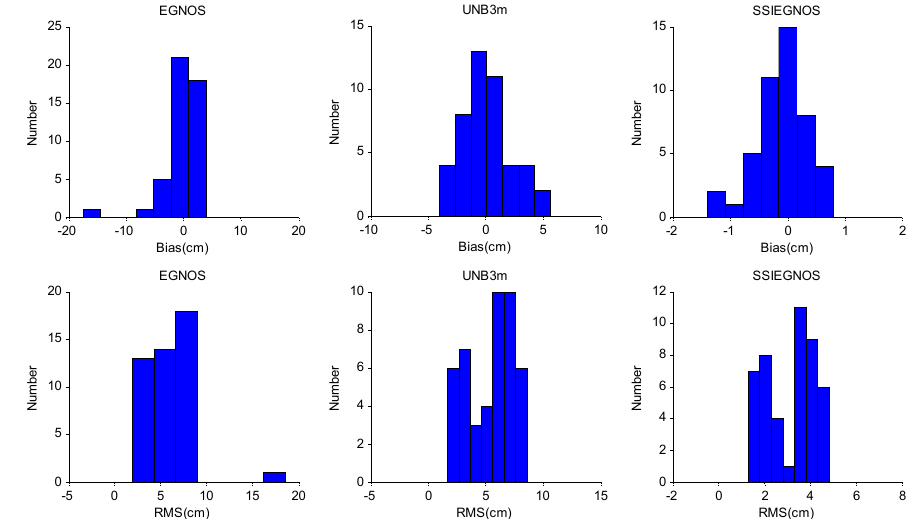
Figure 10. Distribution histogram of predicted bias and RMS error of the EGNOS, UNB3m, and SSIEGNOS models over Asia in 2011. The left shows the EGNOS model results, the middle shows the UNB3m model results, and the right shows the SSIEGNOS model results. The vertical axis denotes the number of samples.